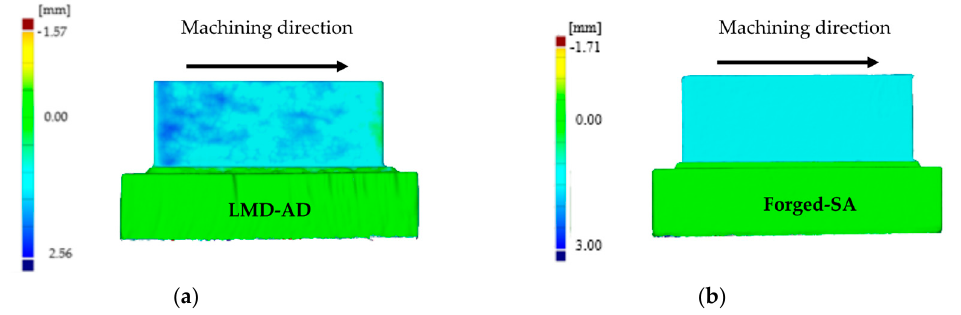
Figure 11. Radial depth of cut for the first set of experiments (face 1): ( a ) LMD-AD wall; ( b ) forged-SA wall.